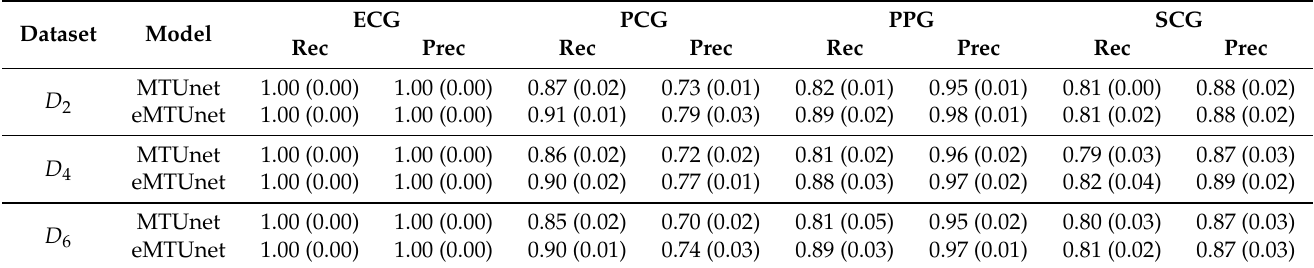
Table 5. Comparison of metrics performances for MTUnet and eMTUnet. Recall and precision are computed for landmark identification task. Each value was evaluated with a ten-fold cross-validation on both D 2 , D 4 , and D 6